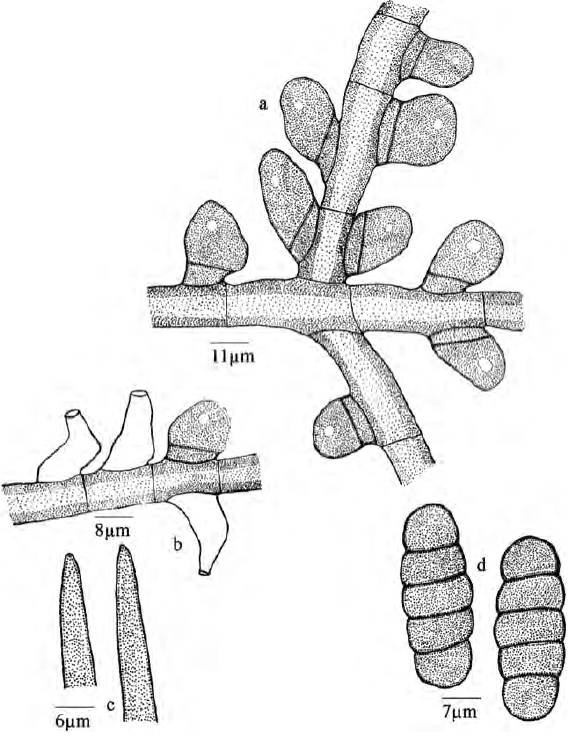
Figure 75. Meliola gemellipoda a - Appressorium; b - Phialide; c - Apical portion of mycelial setae; d -